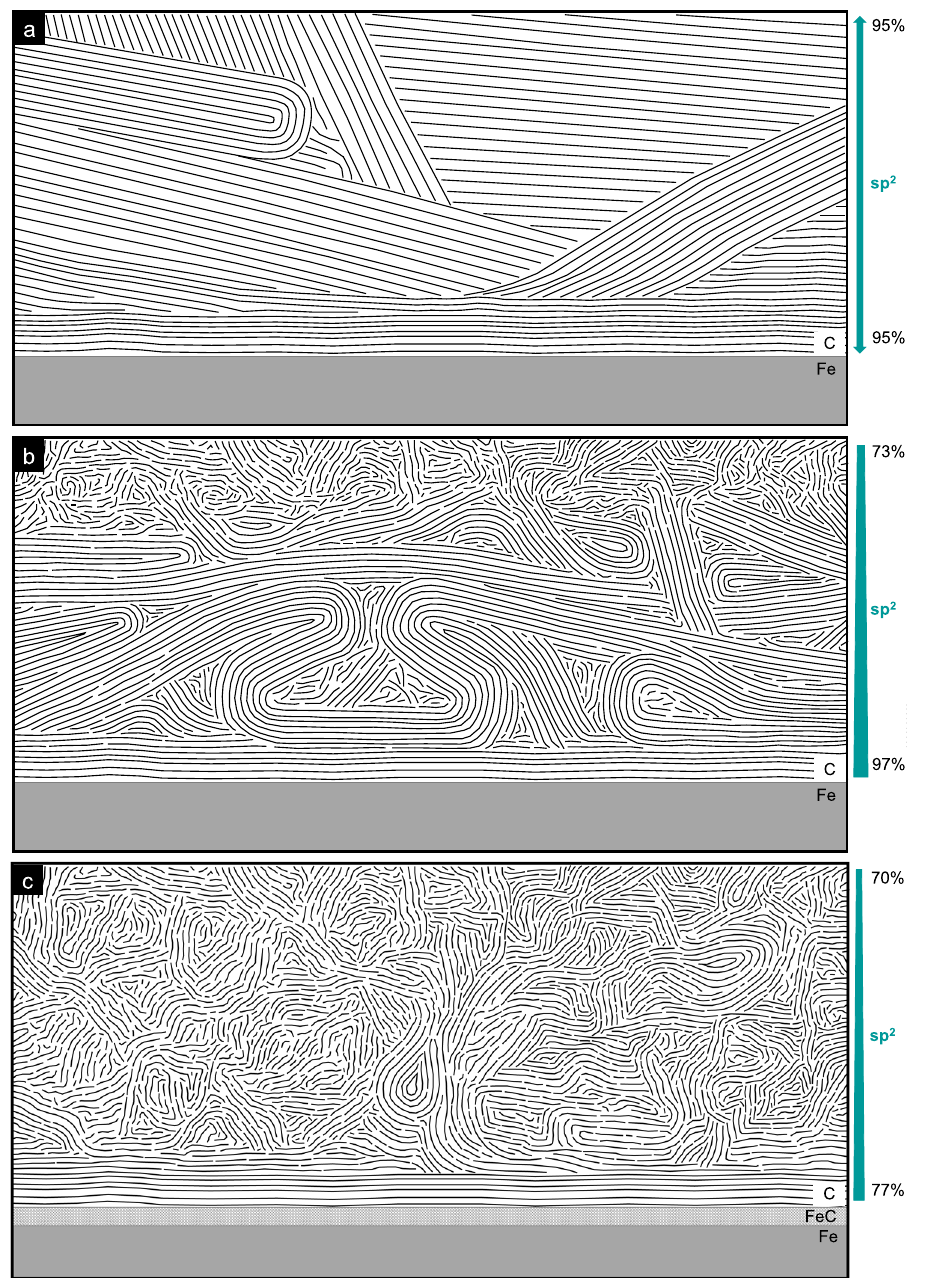
Fig. 7 | Schematic of the structure in the graphite solid lubricant. Structure prior to ( a ) and after sliding experiment with low ( b ) and high load ( c